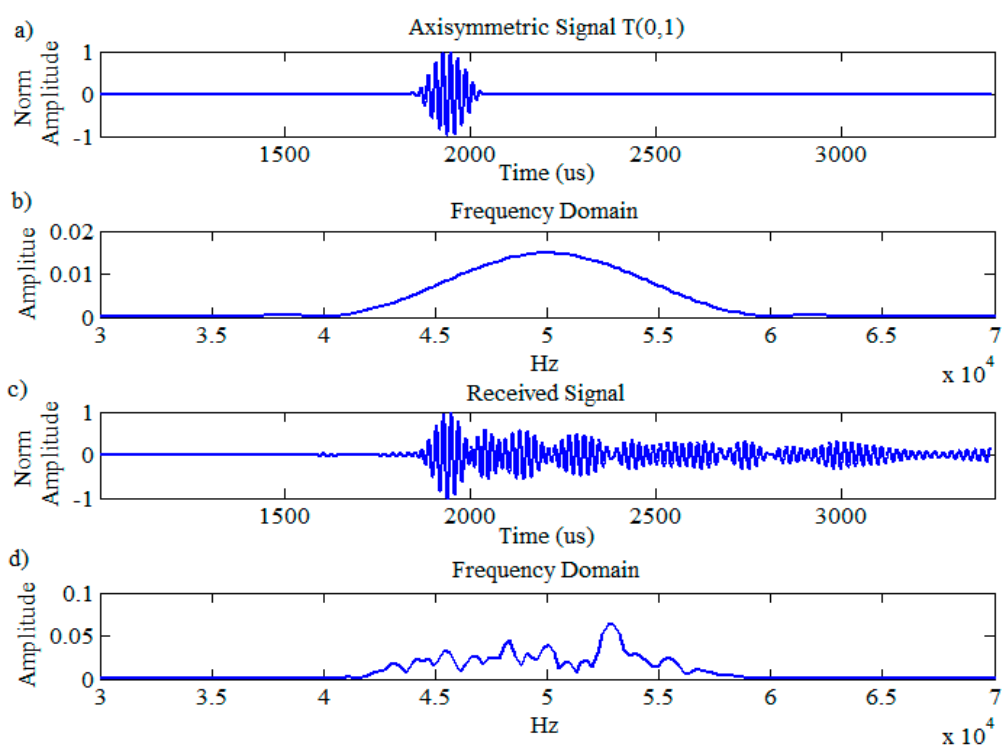
Figure 1. Guided wave excitation signal: ( a ) time; ( b ) frequency domains, received signal; ( c ) time; ( d ) frequency domains.